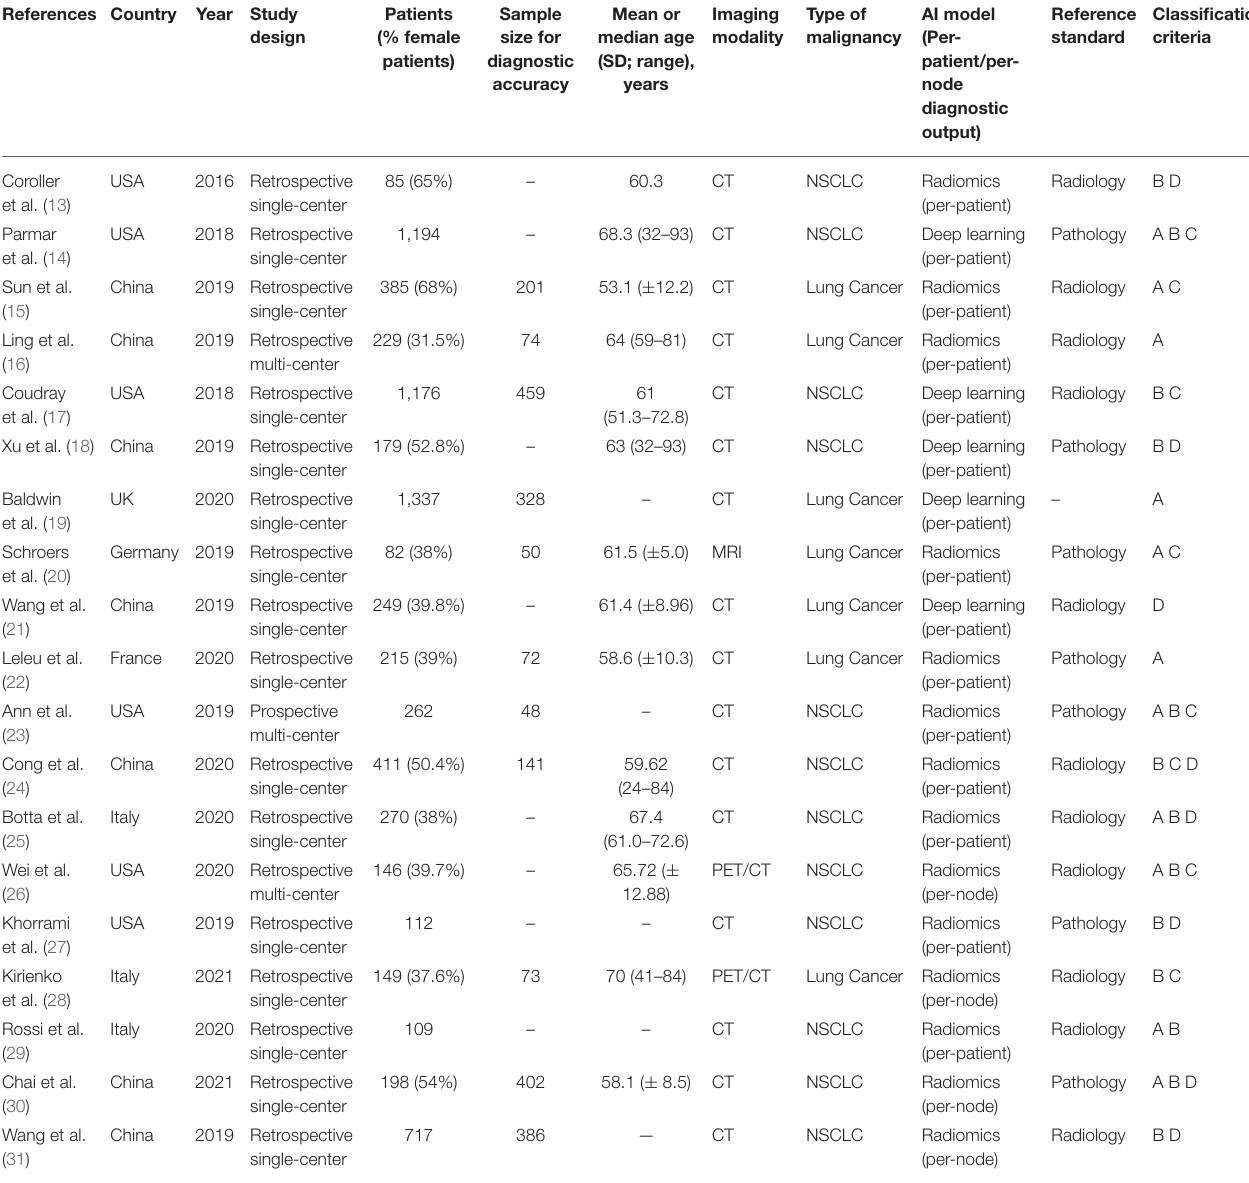
TABLE 3 | Selected characteristics of included